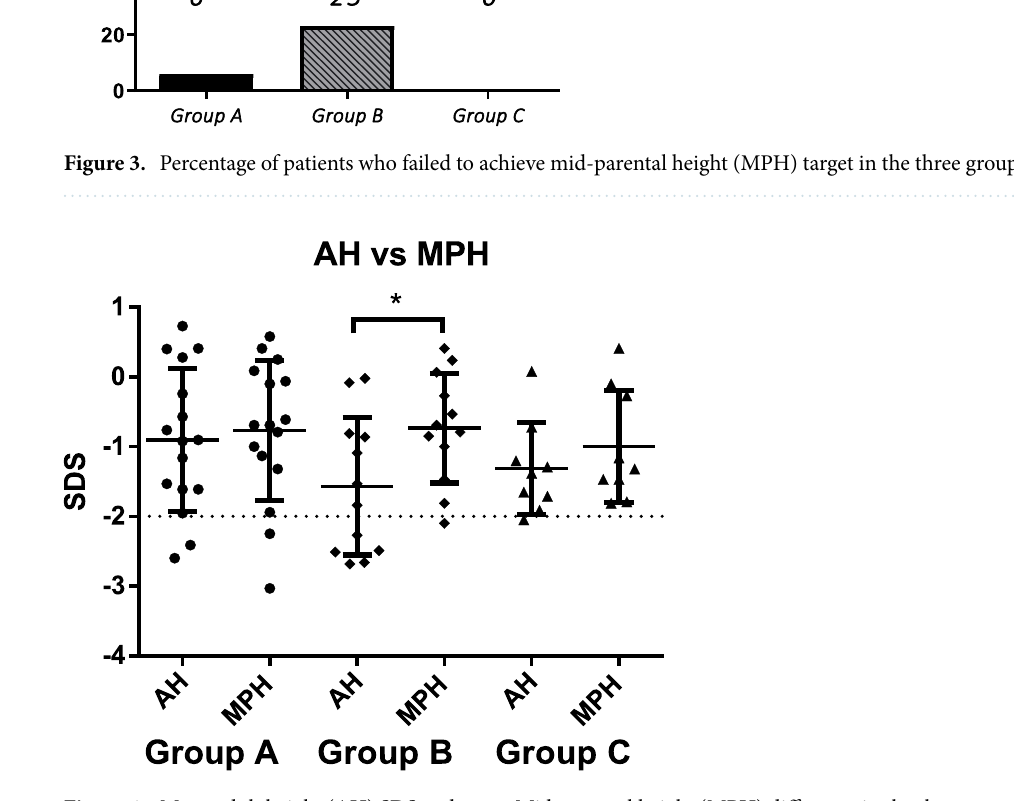
Figure 4. Mean adult height (AH) SDS and mean Mid-parental height (MPH) difference in the three groups. *: P =